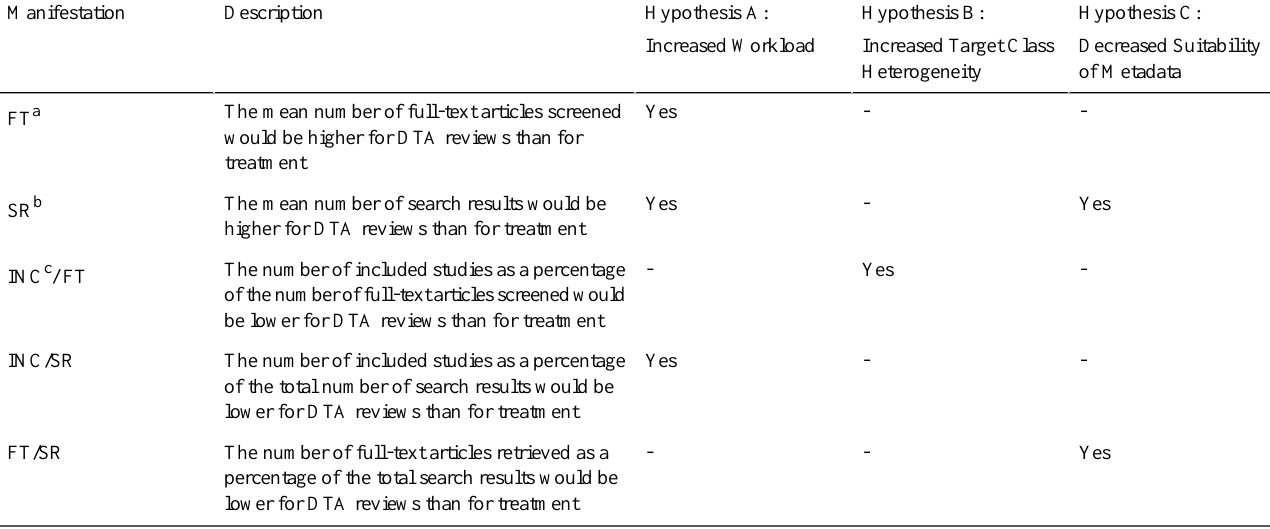
Table 1. List of expected manifestations (differences between DTA and treatment reviews) for all